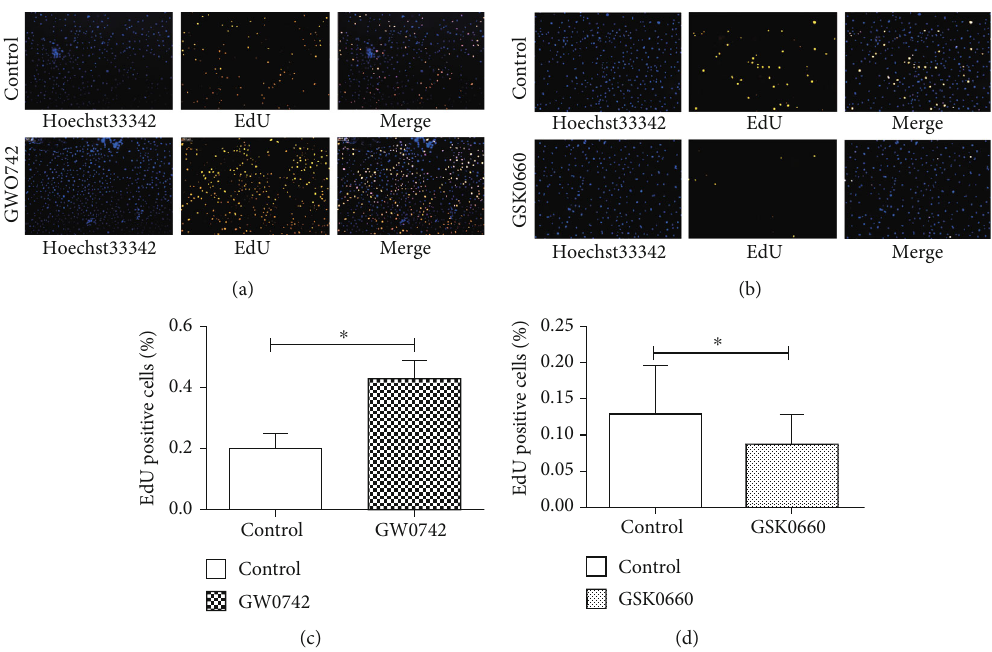
Figure 2: Ligand activation of PPAR β / δ facilitates the proliferation of human cholesteatoma keratinocytes in vitro. (a, c) The e ff ect of GW0742 (a high a ffi nity PPAR β / δ agonist) (a) and GSK0660 (a high a ffi nity PPAR β / δ antagonist) (c) on cell proliferation was detected by EdU assays. (b, d) Data were based on at least three independent experiments and presented as the mean ± SD ; ∗ p < 0 : 05 (vs. control